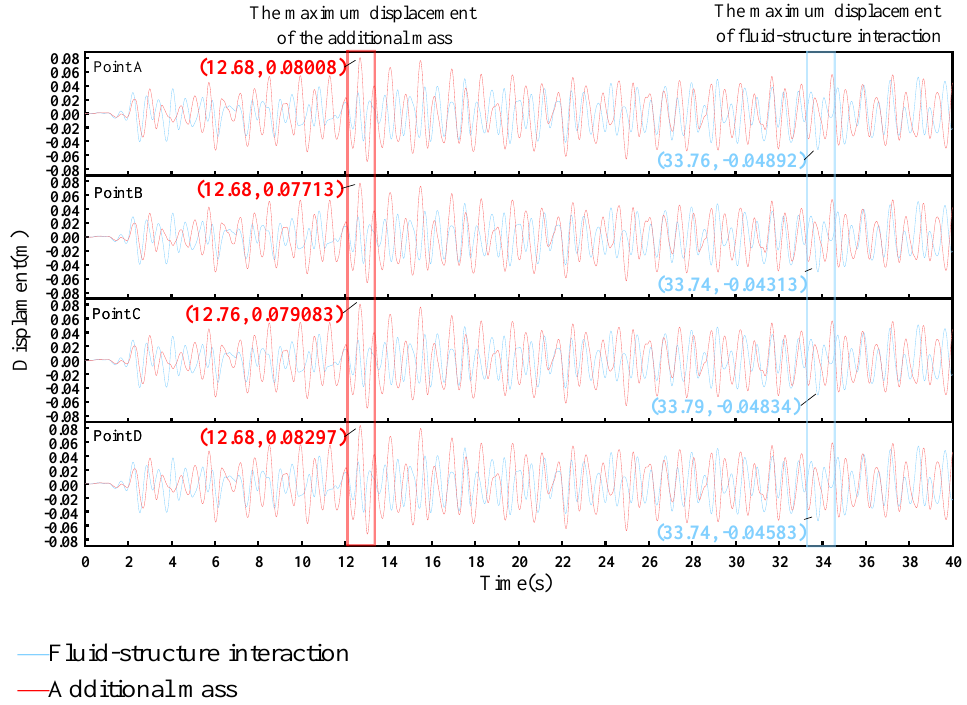
Figure 10. Displacement response time history curve of the right platform pipeline cross-section. From Figures 9 and 10, which depict the seismic displacement response of the pipe- line cross-sectional bridge platform position based on the two methods, it can be seen that the seismic displacement response of the oil pipeline cross-section using the additional- mass method was overwhelmingly larger than that based on the fluid – solid coupling ef- fect. The latter was larger than the former within the first 4 s, after which the former grew in amplitude, influenced by the earthquake, and underwent large displacement changes, reaching a peak at about 13 s. The overall seismic displacement response of the pipeline